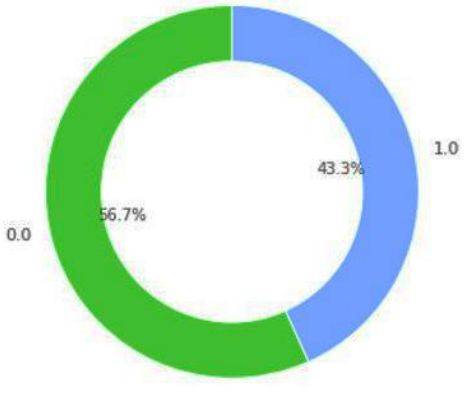
Fig. 6. Ratio of the number of fake news (1) and real news (0) in the collected